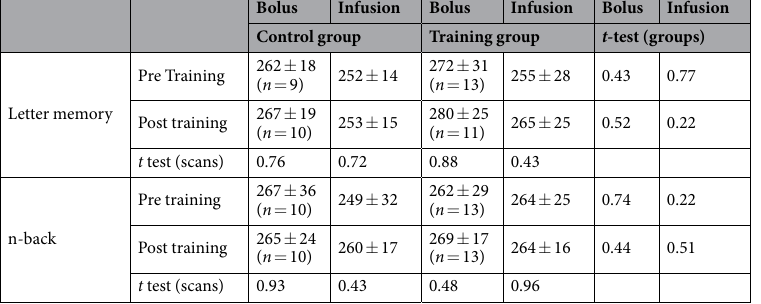
Table 3. Administered radioactivities (MBq; mean ± SD ) in fast bolus and constant infusion formulations, and p -values in t -tests across groups and